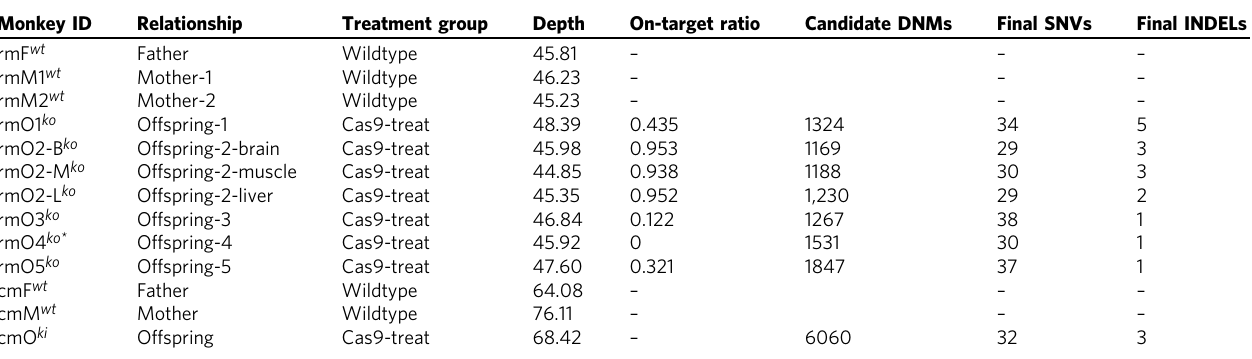
Table 1 Summary of trio WGS and identi fi cation of DNMs. Monkey ID